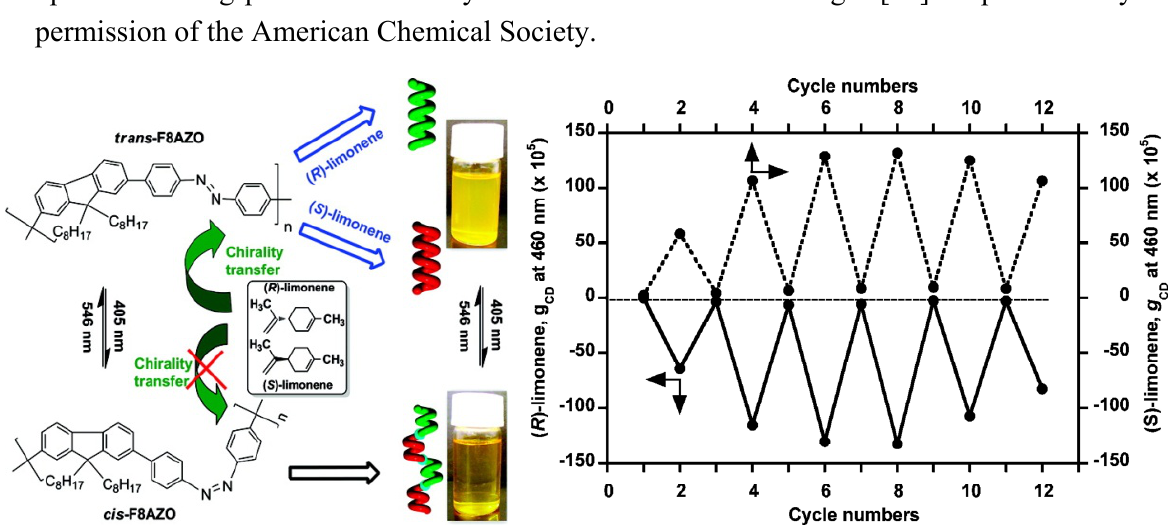
value at 460 nm CD